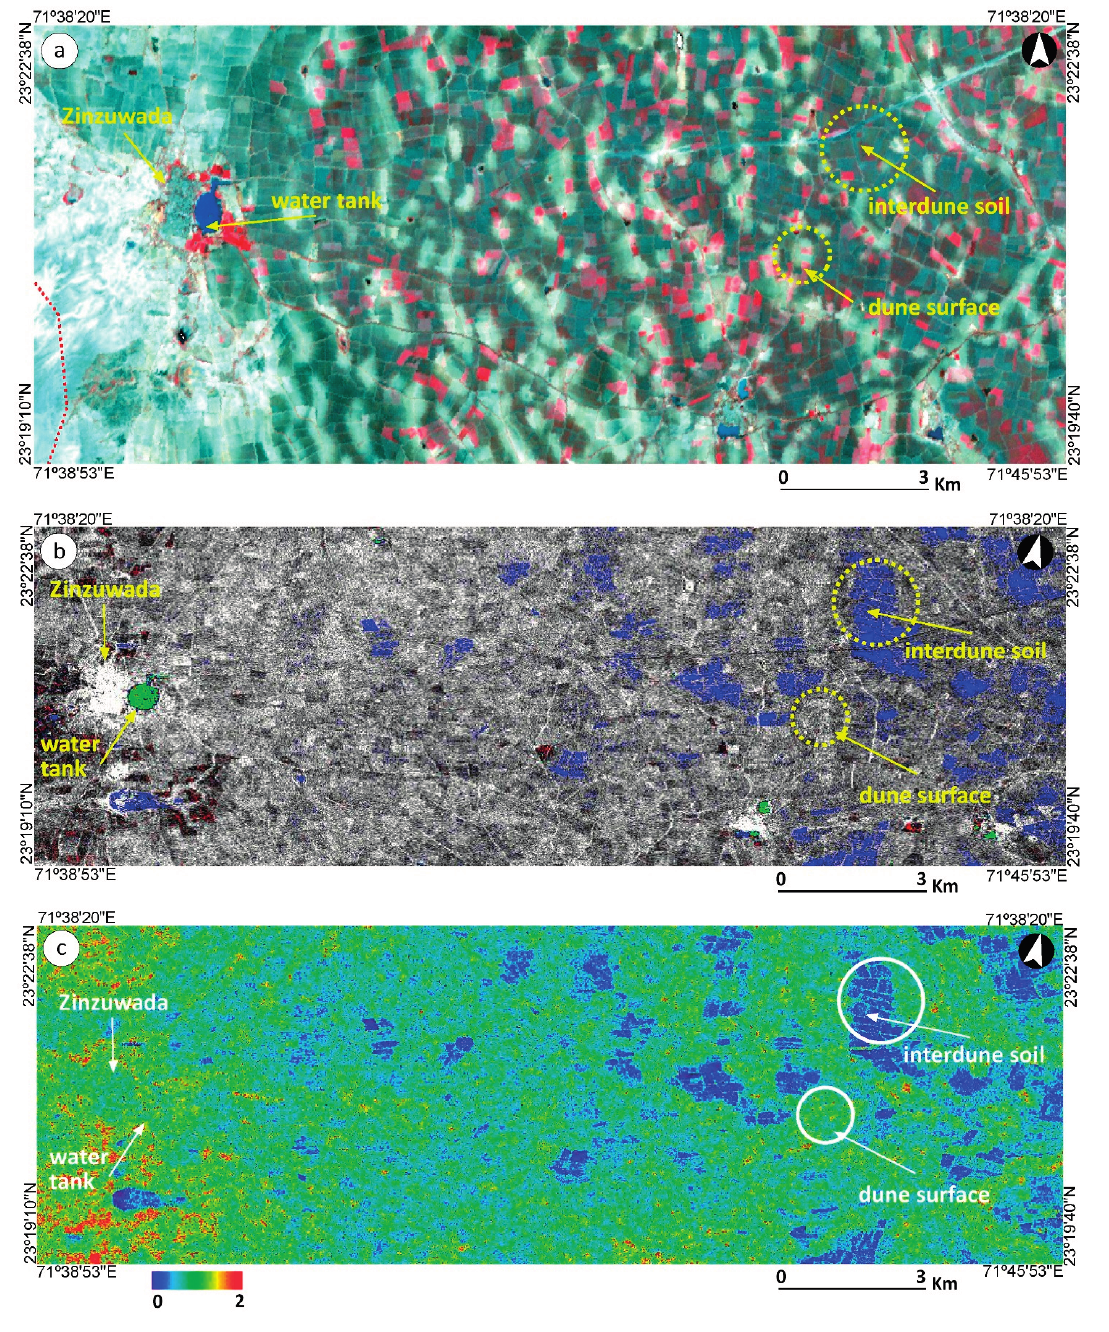
Figure 8. ( a ) Dune-interdune (DI) subset of interest in orthorectified ASTER false colour composite (3N-2-1) from 1 October 2004; ( b ) Integrated seasonal flooding map (blue for monsoon, red for post-monsoon and green for no change); ( c ) Seasonal MA change values (stretched